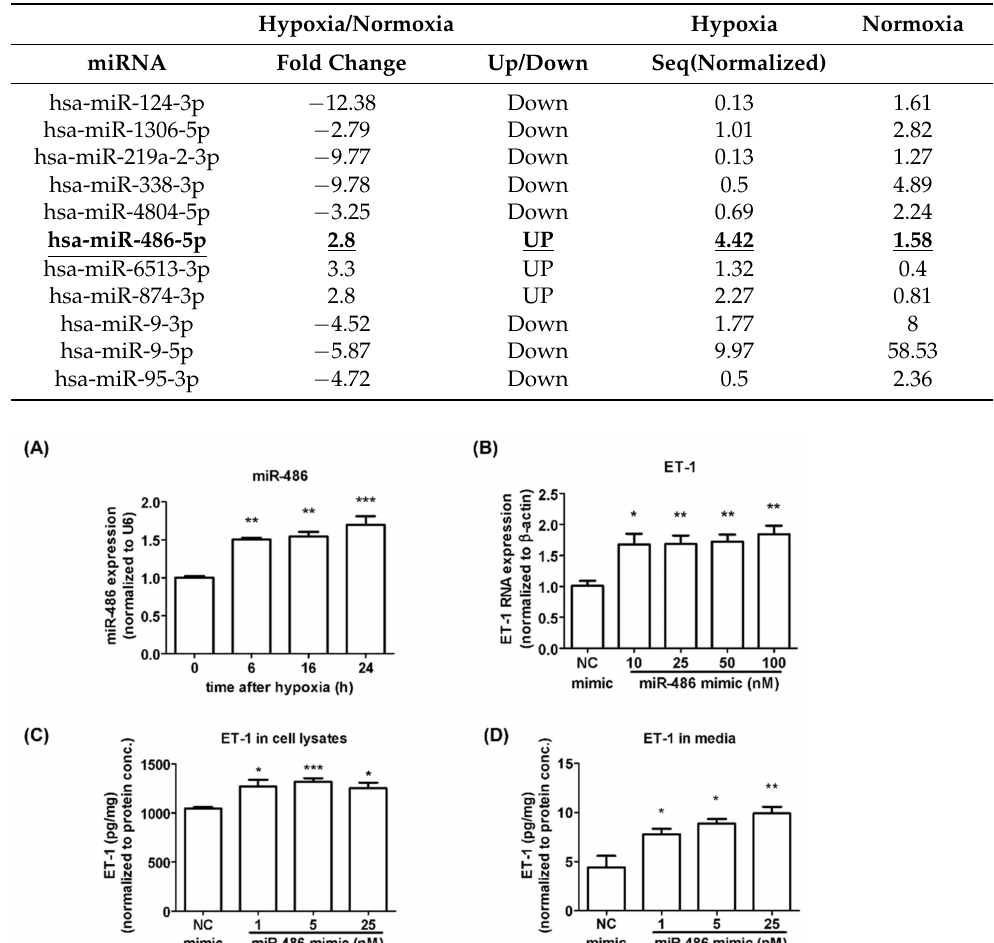
Table 1. Results of miRNA alterations in HPASMCs under hypoxia.